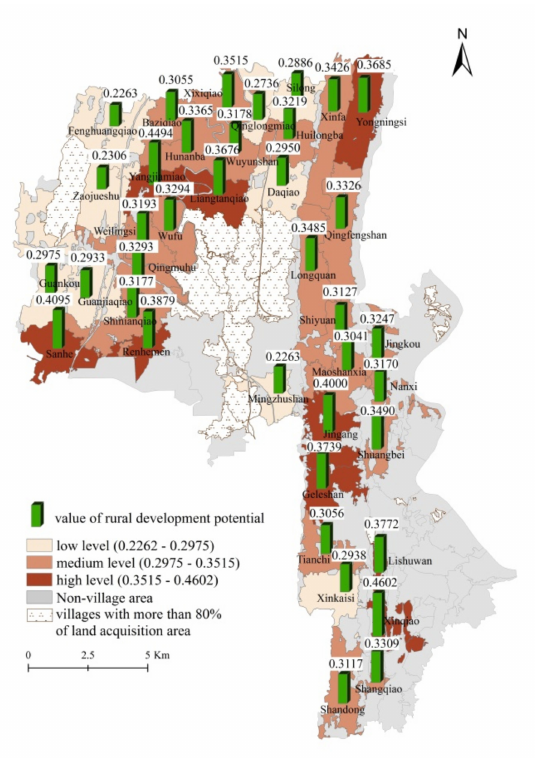
Figure 3. Spatial distribution of rural development potential in Shapingba